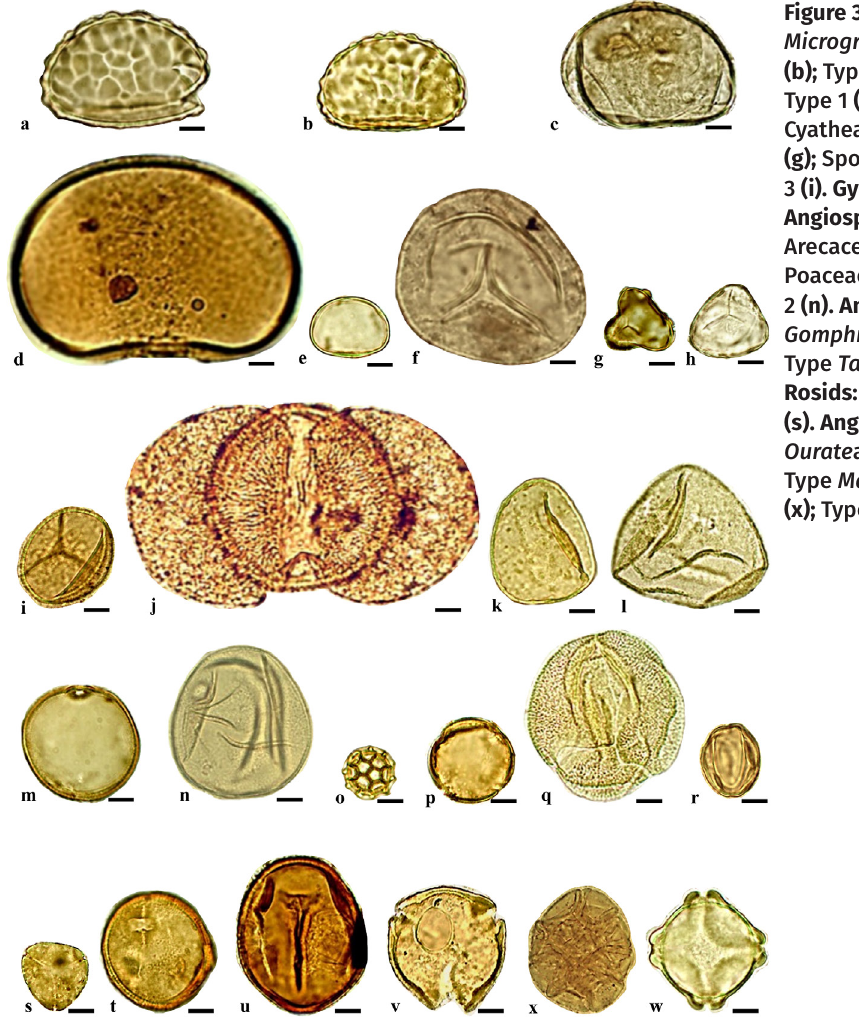
Figure 3. Monilophytes: